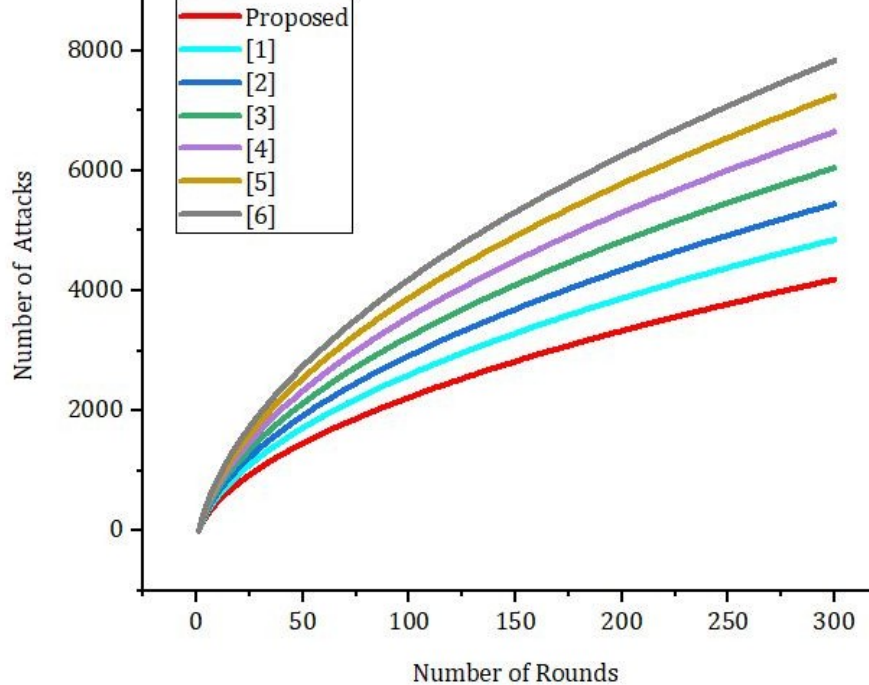
Figure 12. Simulation results based on the bandwidth and number of rounds.